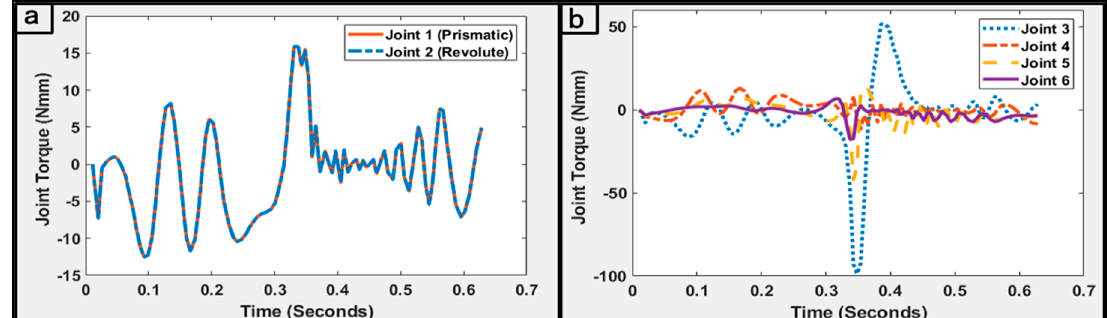
Figure 8. Dynamic analysis of the generalized forces in the robotic mechanism for the trajectory case where n = 10 ( a )joint torque at the first two links; and ( b ) joint torque at the last four